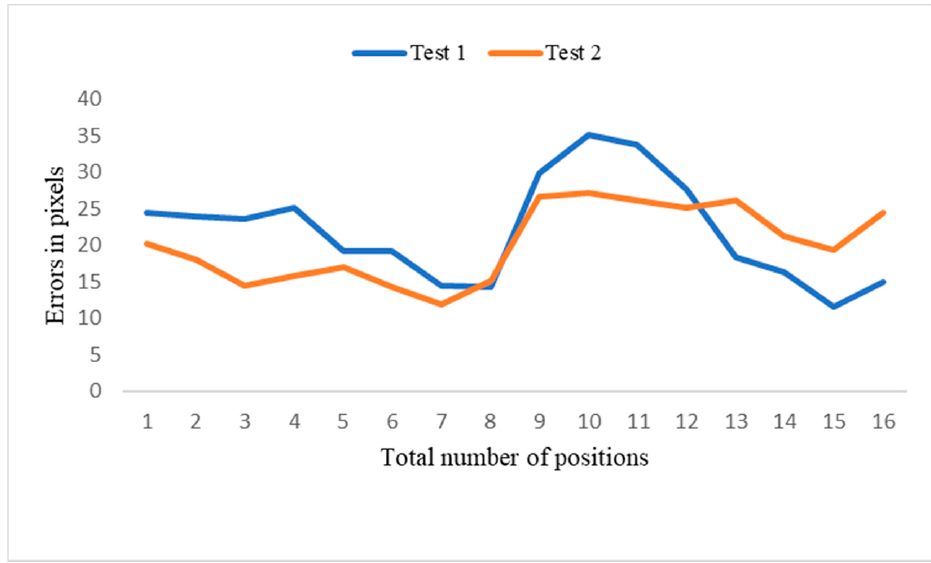
Figure 20. The distance error between test 1 and test 2. Table 5. Error analysis of object position correction system (in